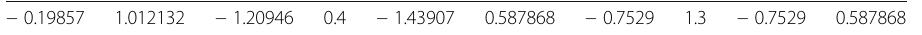
Table 2 u is the original signal −